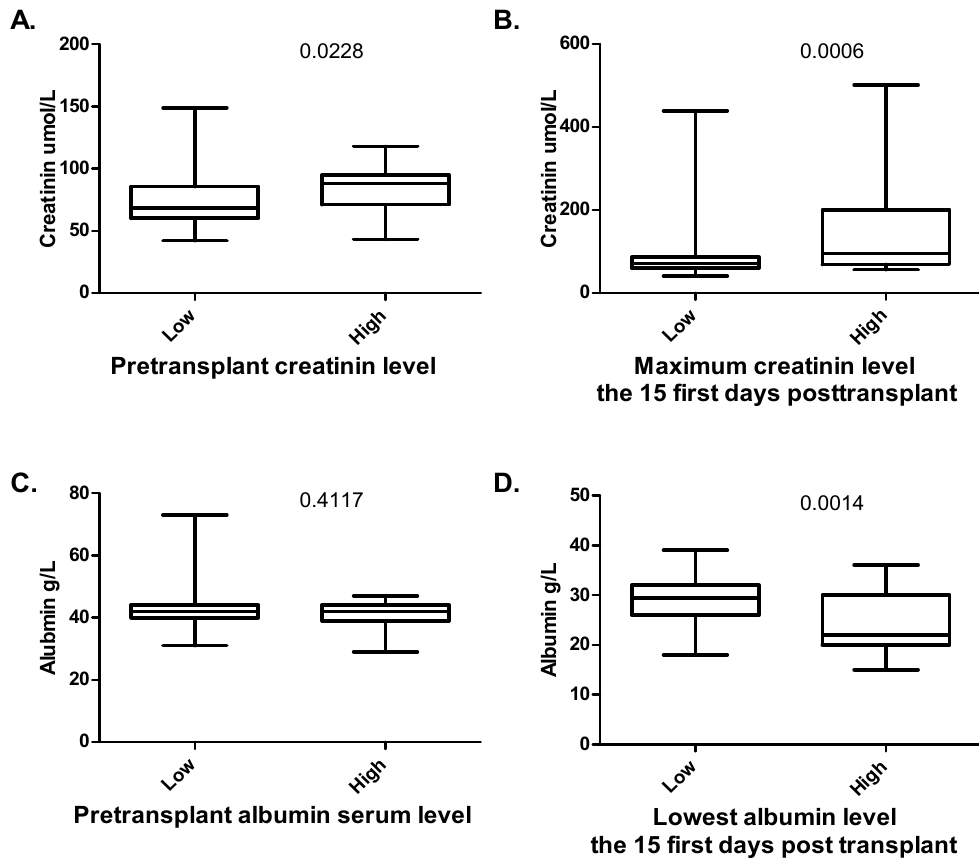
Figure 1. Maximal weight gain (i.e., fluid retention) early after allogeneic stem cell transplantation—a comparison between patients with weight gain below ( low ) or above ( high ) 5 kg. The figure shows the comparison of: ( A ) pretransplant creatinine serum level; ( B ) the highest observed creatinine level before Day +15 posttransplant; ( C ) pretransplant albumin levels; and ( D ) the lowest albumin level before Day +15 posttransplant. The Mann–Whitney U -test was used for the analyses; the corresponding p -value is given in the upper right for each part of the figure.